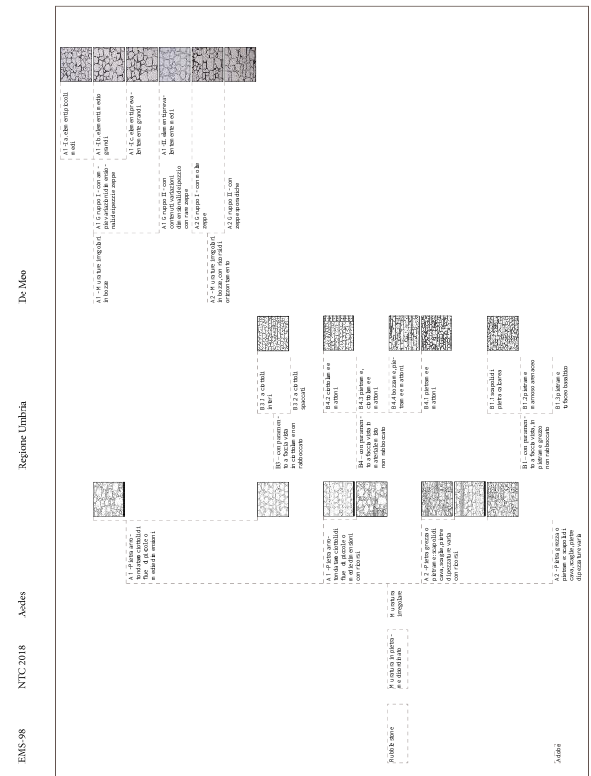
Figure 1. Synoptic map of